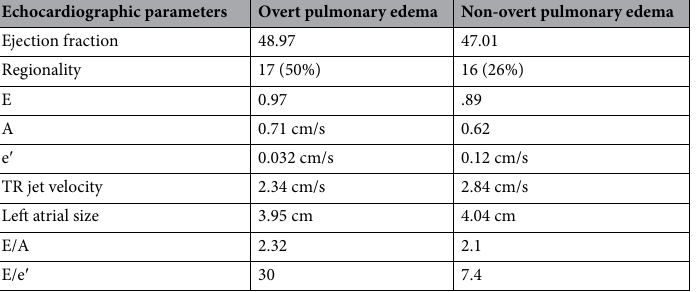
Table 2. Echocardiographic findings: E early mitral inflow doppler velocity, A late mitral inflow (Atrial contraction) doppler velocity, e ʹ early mitral annular velocity measured by tissue doppler, TR tricuspid regurgitation velocity.